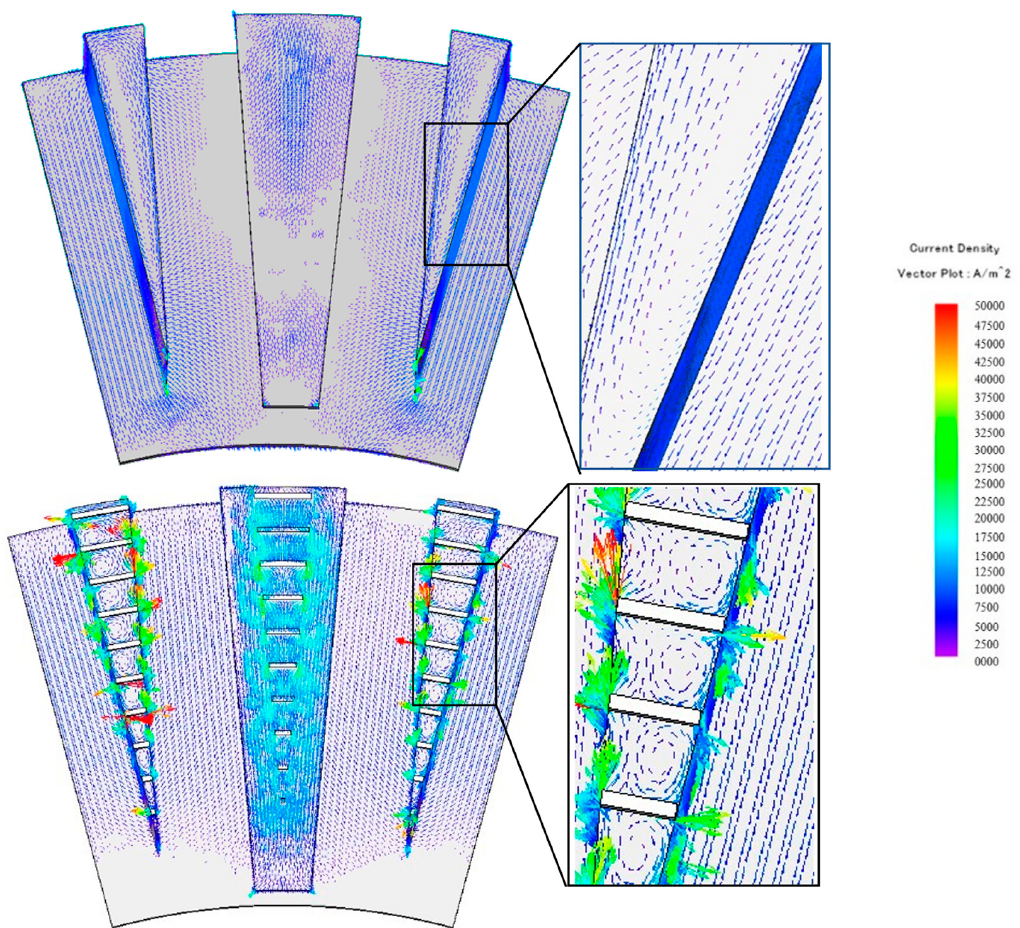
Figure 6. Upper image and under image shows the comparison of eddy current loss path [16].